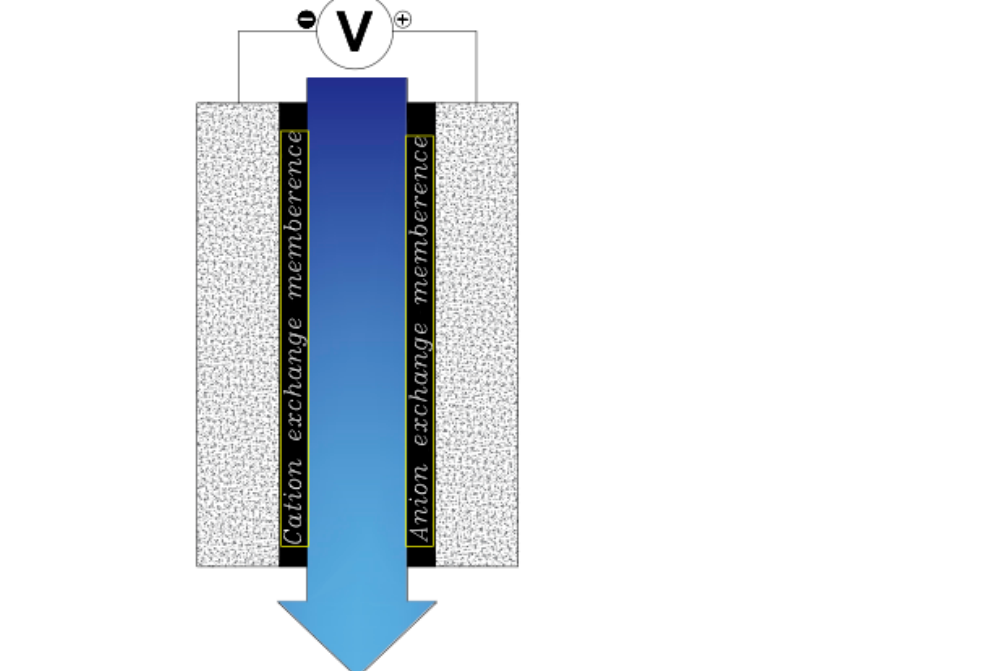
Figure 7. Wire electrode in a CDI cell. Another method that works like electrochemical current capacitors is known as Flow Capacitive Deionization (FCDI) [23]. In this method, instead of solid carbon, a type of slurry carbon is used in the role of an electrode and the flow of salt water and slurry car- bon are in contact with the current (Figure 8). As the slurry is charged, the salt particles